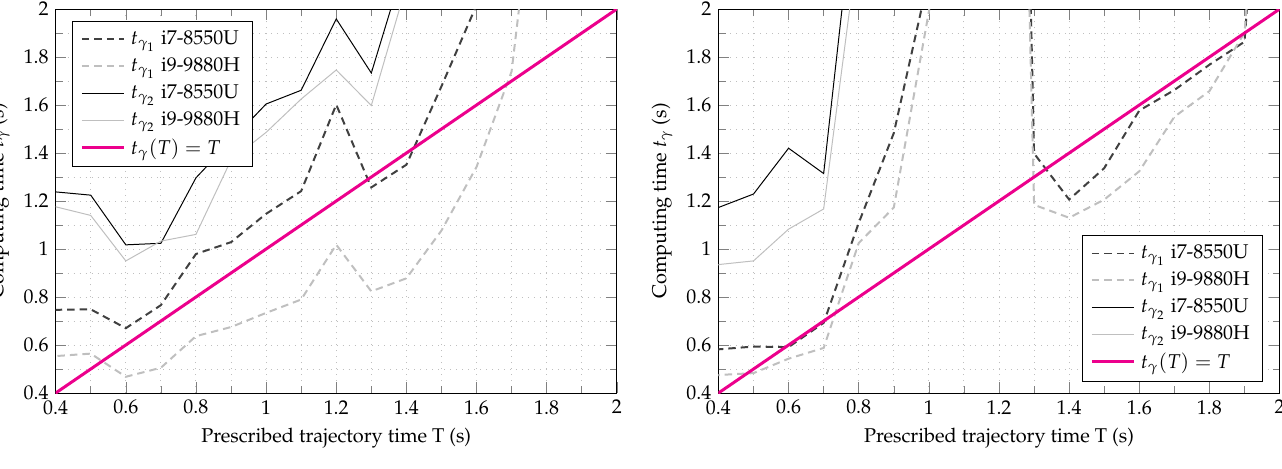
Figure 4. CPU computing time required to obtain a solution with γ 1 and γ 2 . Results for two processors: Intel i7-8550U and Intel i9-9880H on a prescribed trajectory time window comprised between 0.4and 2s. Values that remain below the solid straight line correspond to optimal trajectories that take less time to compute than they require to complete ( t γ ( T ) < T ). Real-time optimal control or motion replanning could be considered in these